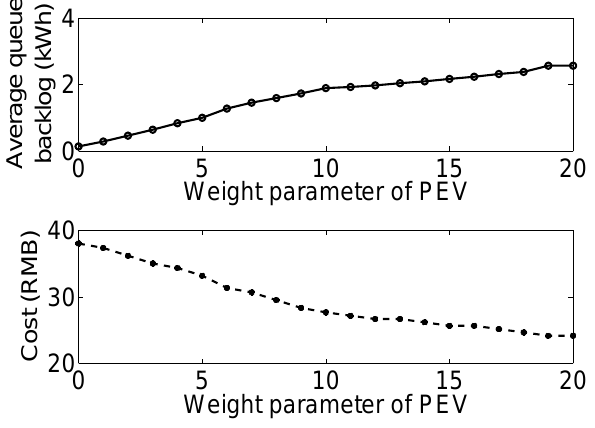
Figure 12. Average delay queue backlog of PEV and the electricity bills of controllable